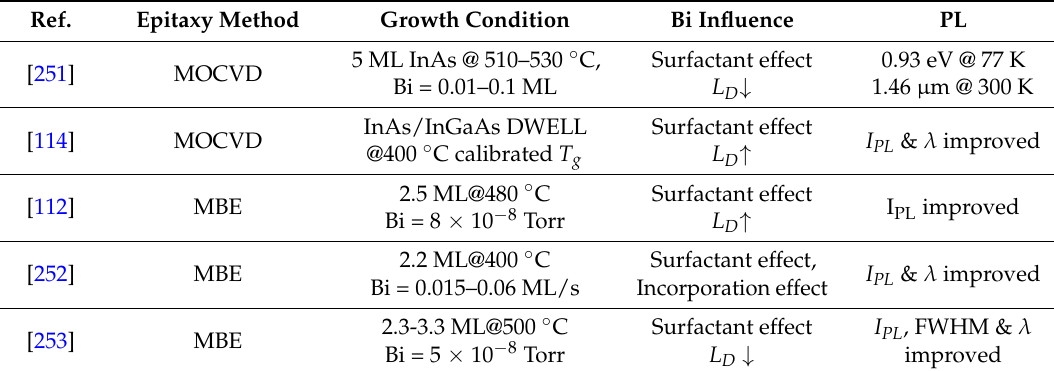
Table 7. Summary of reports about Bi influence on quantum dots